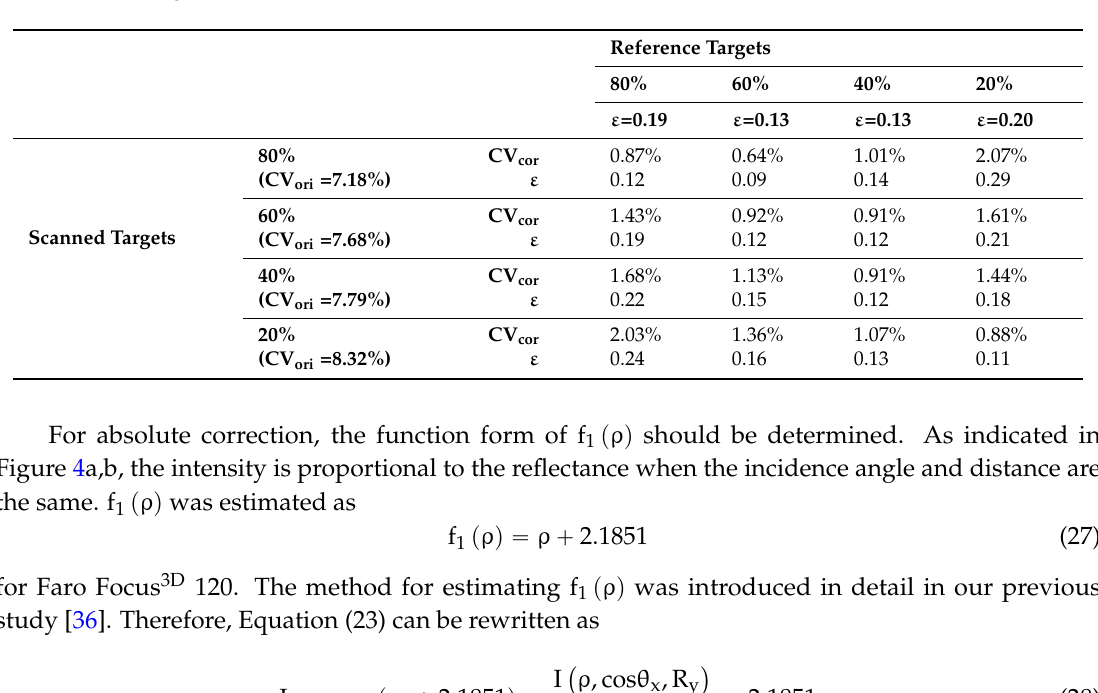
Table 4. Correction results of the four targets at scanning geometries from A to L when different reference targets are used.